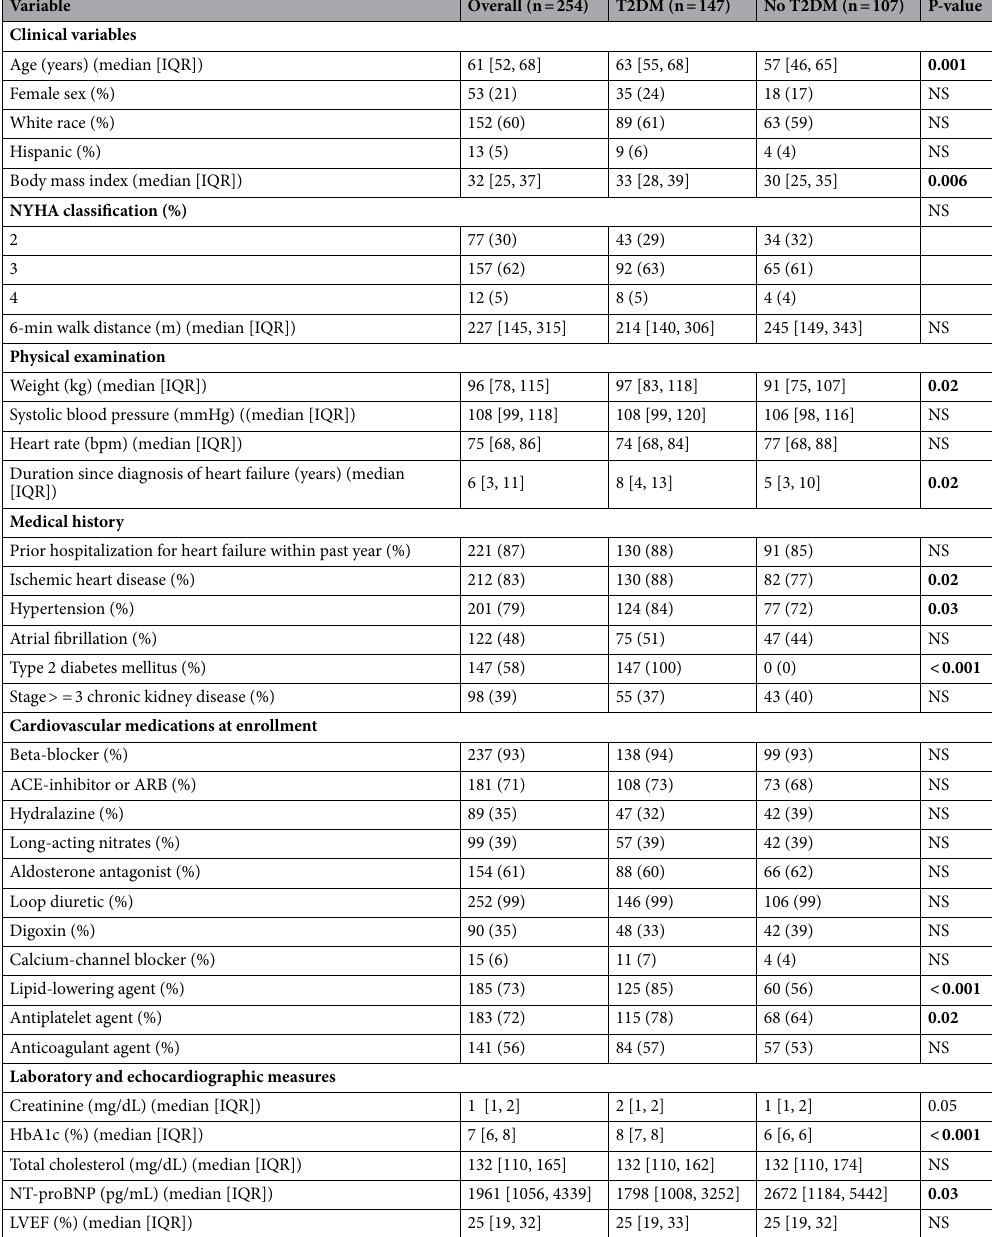
Table 1. Baseline characteristics of the study cohort. Significant values are in